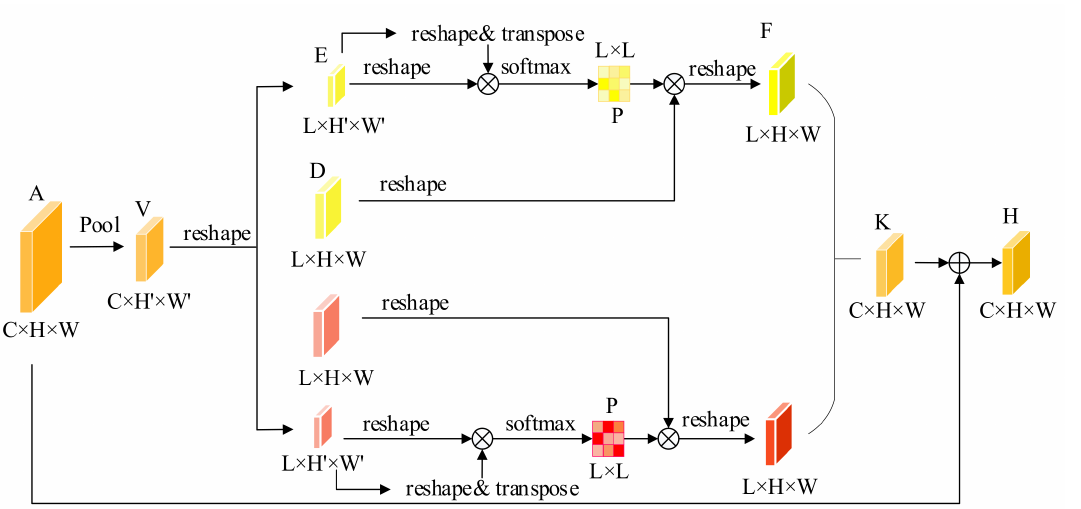
Figure 5. The structure of CA